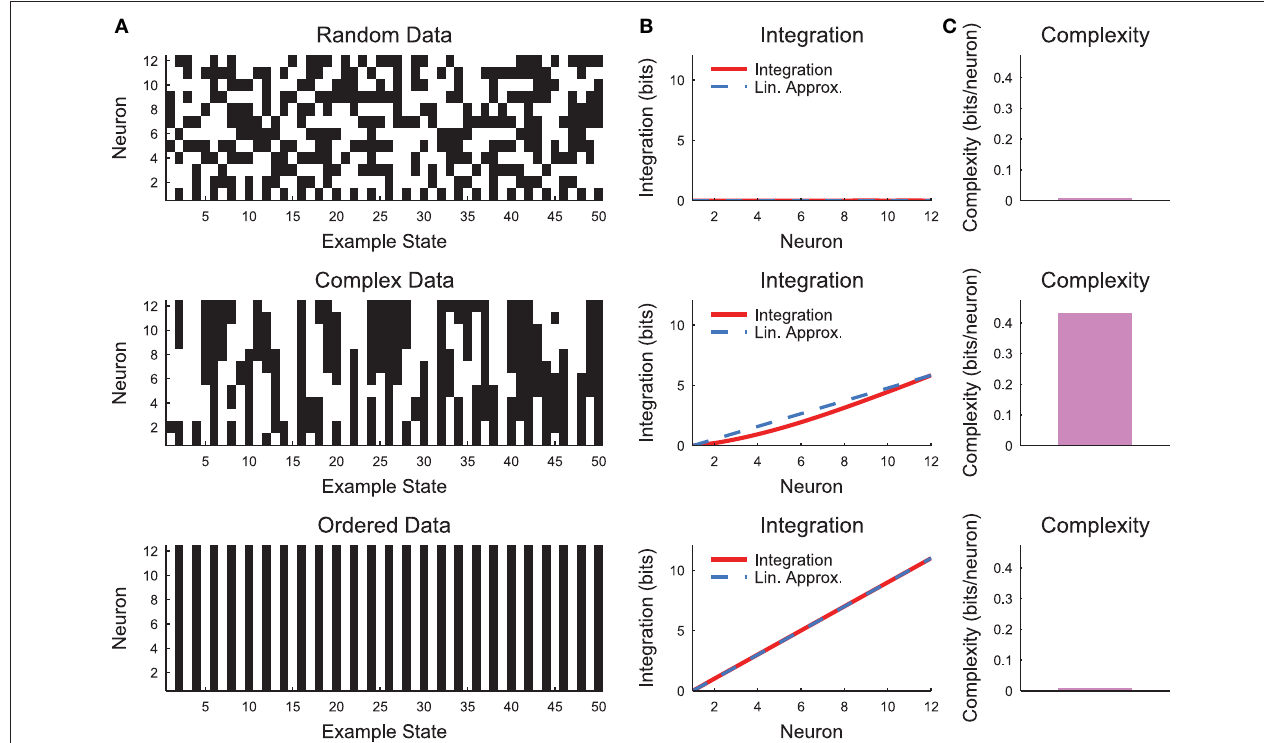
FIGURE 3 | Neural complexity. (A) Short segments of example spike rasters for three types of chain model data (see Section 2.4, c = 0 (random), c = 0.8 (complex), c = 1 (ordered)). (B) Integration curves with linear approximations for different subset sizes. Note that random data shows no integration, while ordered data shows high integration. Complex data shows high integration that varies non-linearly with subset size. (C) Complexity values. Only the complex data shows non-zero complexity.